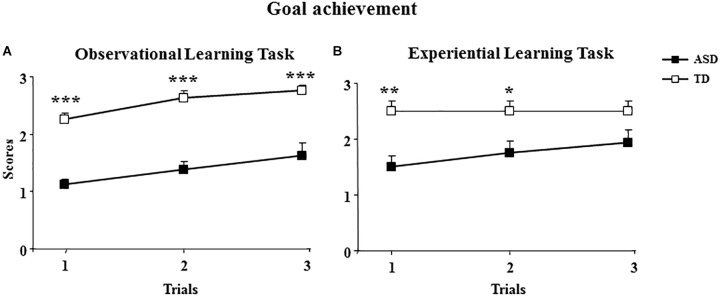
Behavioral results of ASD and TD children. Performance of ASD and TD children in the observational learning task (A) and experiential learning task (B). Data are presented as mean ± SEM. Asterisks indicate the significance level of comparisons between groups: ∗p < 0.05, ∗∗p < 0.005, and ∗∗∗p < 0.0005.